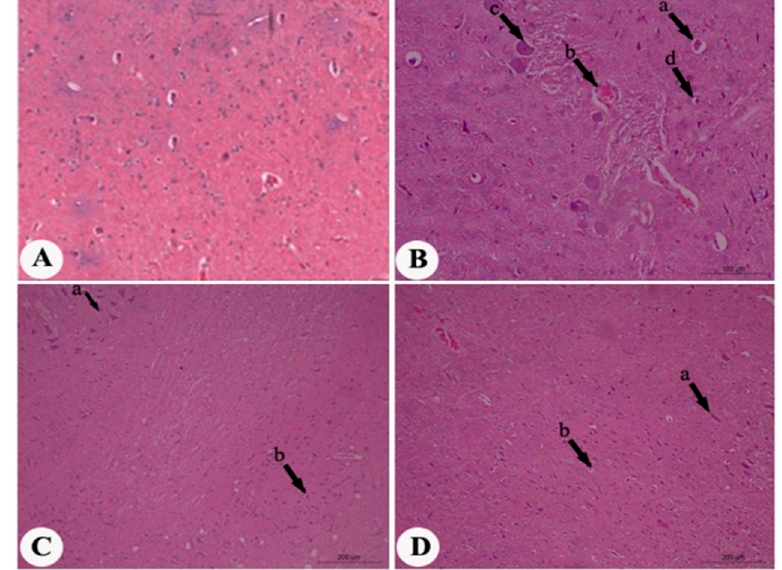
Figure 17. Photomicrographs of brain cerebral cortex sections stained with hematoxylin and eosin (H&E) of at two months MSG post-treatment (magnification: 400 × ). ( A ) Brain sample from normal control rats showing distinct neurons and normal glial cells with no vacuolation; ( B ) brain sample from rats treated with MSG showing perivascular edema (arrow a), congestion (arrow b), severe neuronal degeneration and pyknosis (arrow c), pericellular edema (arrow d); ( C ) brain samples from rats treated with MSG and ginger, showing moderate neuronal degeneration (arrow a) and mild pericellular edema (arrow b); ( D ) brain sample from rats treated with MSG and propolis, showing mild neuronal degeneration (arrow a) and mild pericellular edema (arrow b).